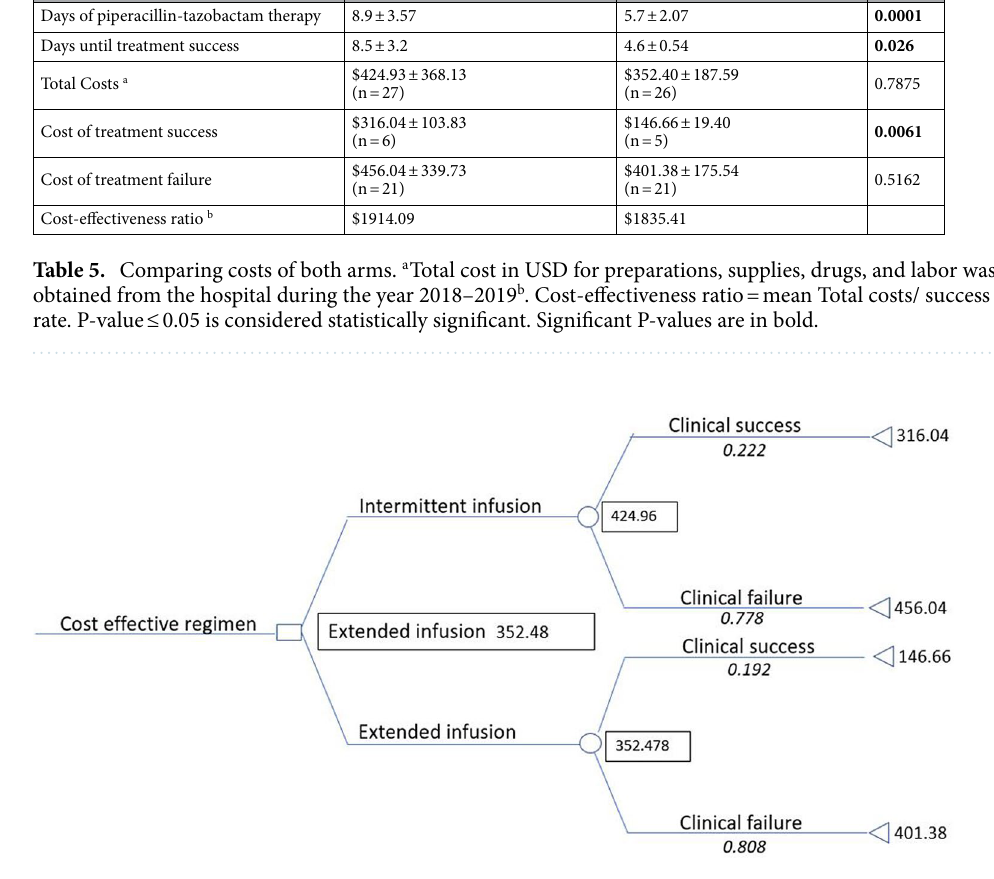
Figure 2. Decision tree results of drug acquisition economic analysis of intermittent infusion piperacillin- tazobactam compared with the extended